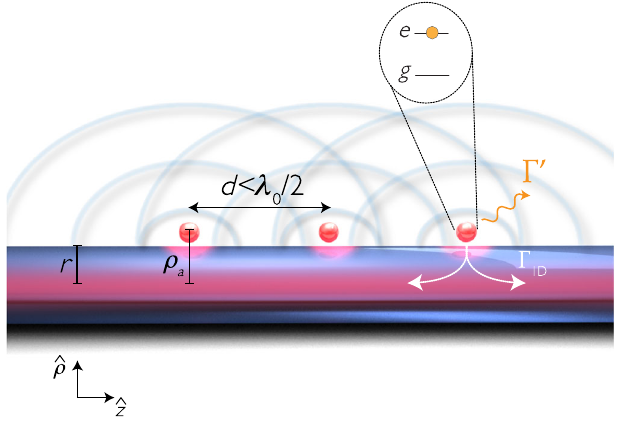
FIG. 11. Schematic of the setup under consideration: N two- level atoms are located in the vicinity of a dielectric nanofiber of dielectric constant ϵ and radius r , at a distance ρ of the fiber, and at a constant distance d from each other. For the calculations in this paper, we take k 0 r ¼ 1 . 2 , ρ ϵ ¼ 4 . The atoms interact with each other not only through the guided mode, but also through nonguided photons. The single- atom emission rates into the fiber and into free space are Γ 1 Γ 0 ,